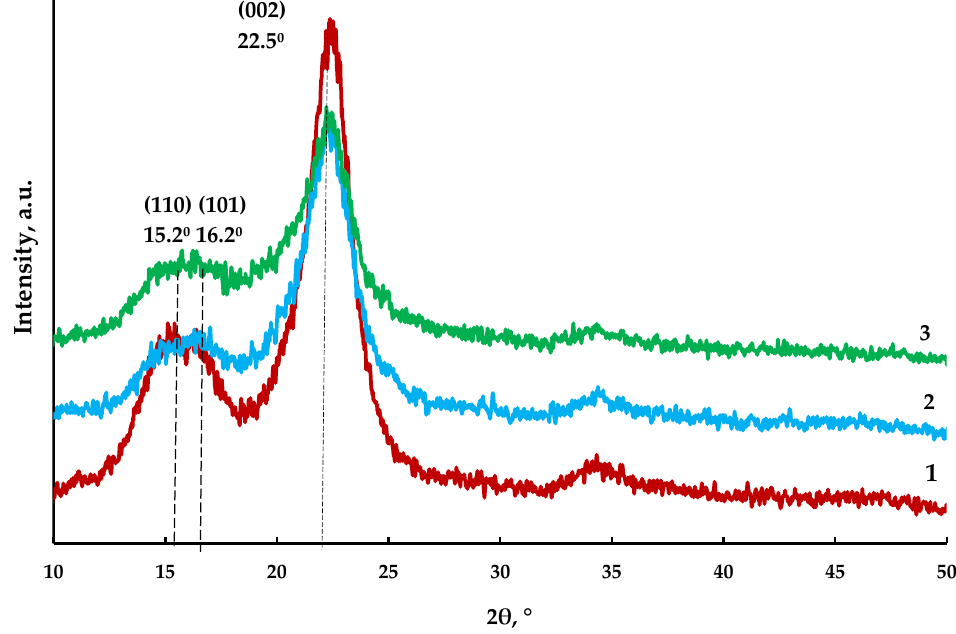
Figure 7. X-ray patterns of cellulose samples: ( 1 ) original cellulose; ( 2 ) MCC; ( 3 ) MFC.